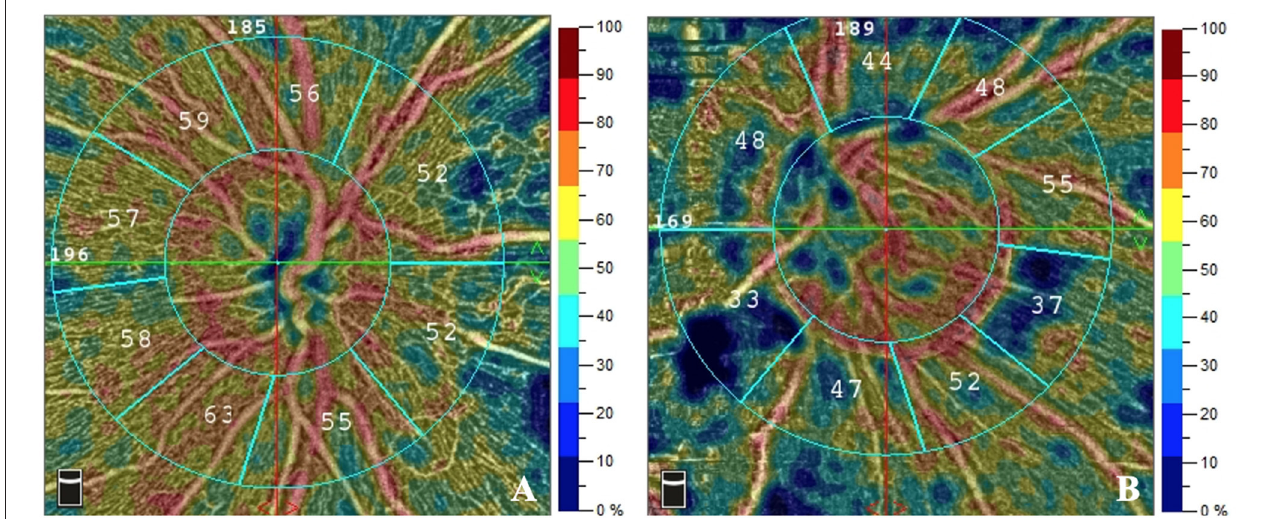
FIGURE 1 | The RPC density of patients with different Fazekas scores of DWMLs. The RPC density evaluated by OCTA was 56.1% in a patient with Fazekas score 1 (A) and 45.0% in a patient with Fazekas score 3 (B) . RPC, radial peripapillary capillary; DWMLs, deep white matter lesions; OCTA, optical coherence tomography